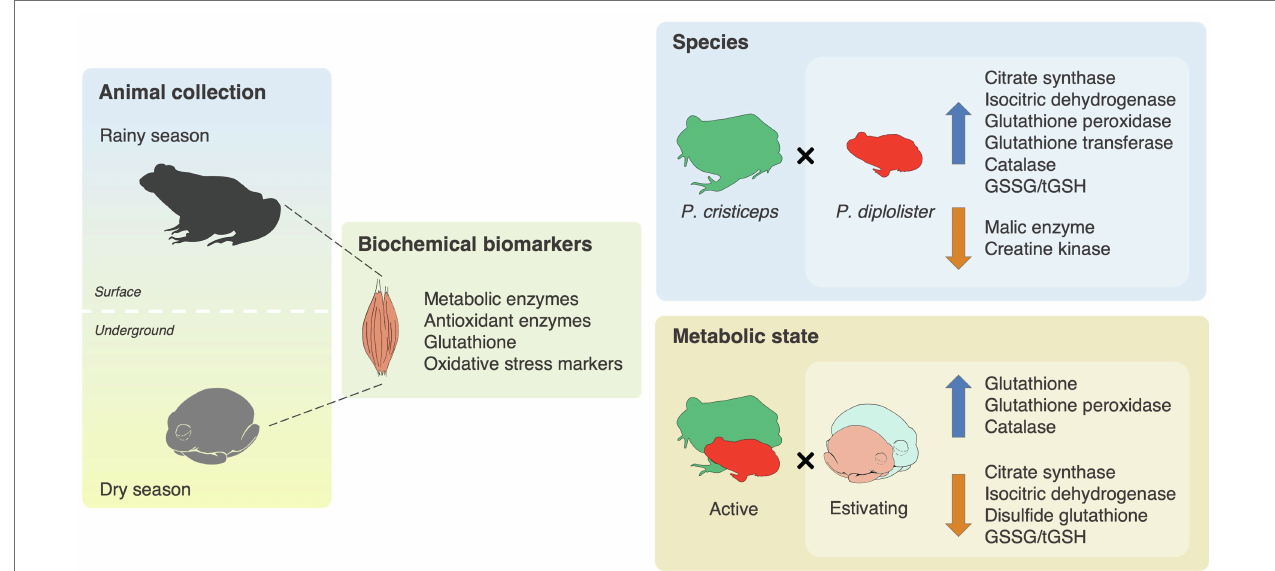
FIGURE 7 | Graphical summary of the biochemical adaptations of two frog species that estivate during the seasonal droughts in the Caatinga. Free-ranging adult specimens of Pleurodema diplolister and Proceratophrys cristiceps were collected during the rainy (active) and the dry season (estivating) in the Caatinga. The whole skeletal mass surrounding the femur was dissected and homogenized for the measurement of biochemical variables. The activities of intermediary metabolism and antioxidant enzymes, the levels of total (tGSH), reduced (GSH) and disulfide (GSSG) glutathione, and the degree of oxidative damage to proteins were measured. Species had an effect on the activities of citrate synthase, isocitric dehydrogenase, glutathione peroxidase, glutathione transferase, catalase, malic enzyme and creatine kinase, as well as on GSSG/tGSH ratio. Estivation had an effect on the activities of citrate synthase, isocitric dehydrogenase, glutathione peroxidase and catalase, as well as on the levels of tGSH, GSH, GSSG, and GSSG/tGSH. The upward arrows indicate variables whose values are higher in P. diplolister (vs. P. cristiceps ) or in estivating frogs (vs. active frogs). The downward arrows indicate variables whose values are lower in P. diplolister (vs. P. cristiceps ) or in estivating frogs (vs. active